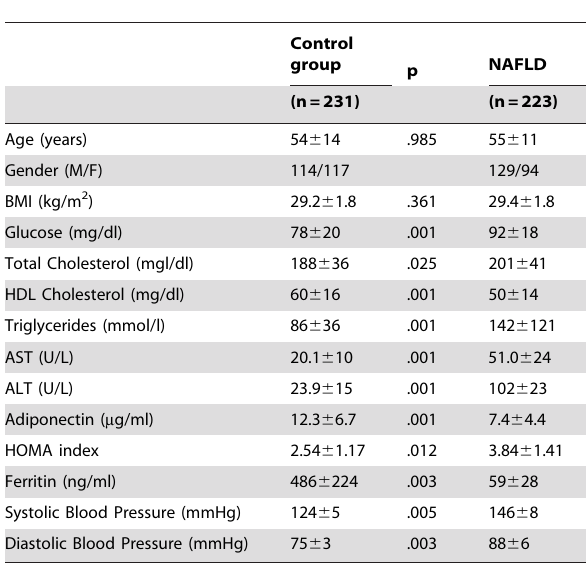
Table 1. Clinical characteristics of NAFLD patients and control